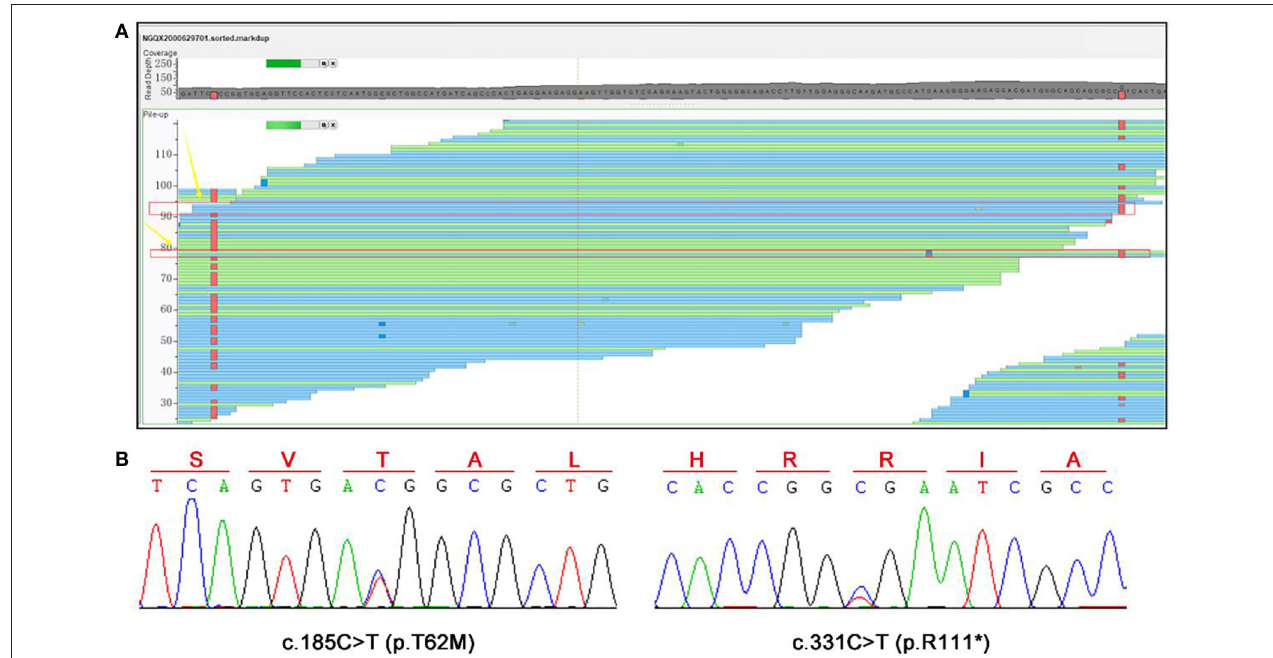
FIGURE 4 | WES and Sanger sequencing results. (A) A compound heterozygous variants of SLC13A3 , c.185C > T (p.T62M), and c.331C > T (p.R111*), were identified. (B) Sanger sequencing was performed to confirm these two